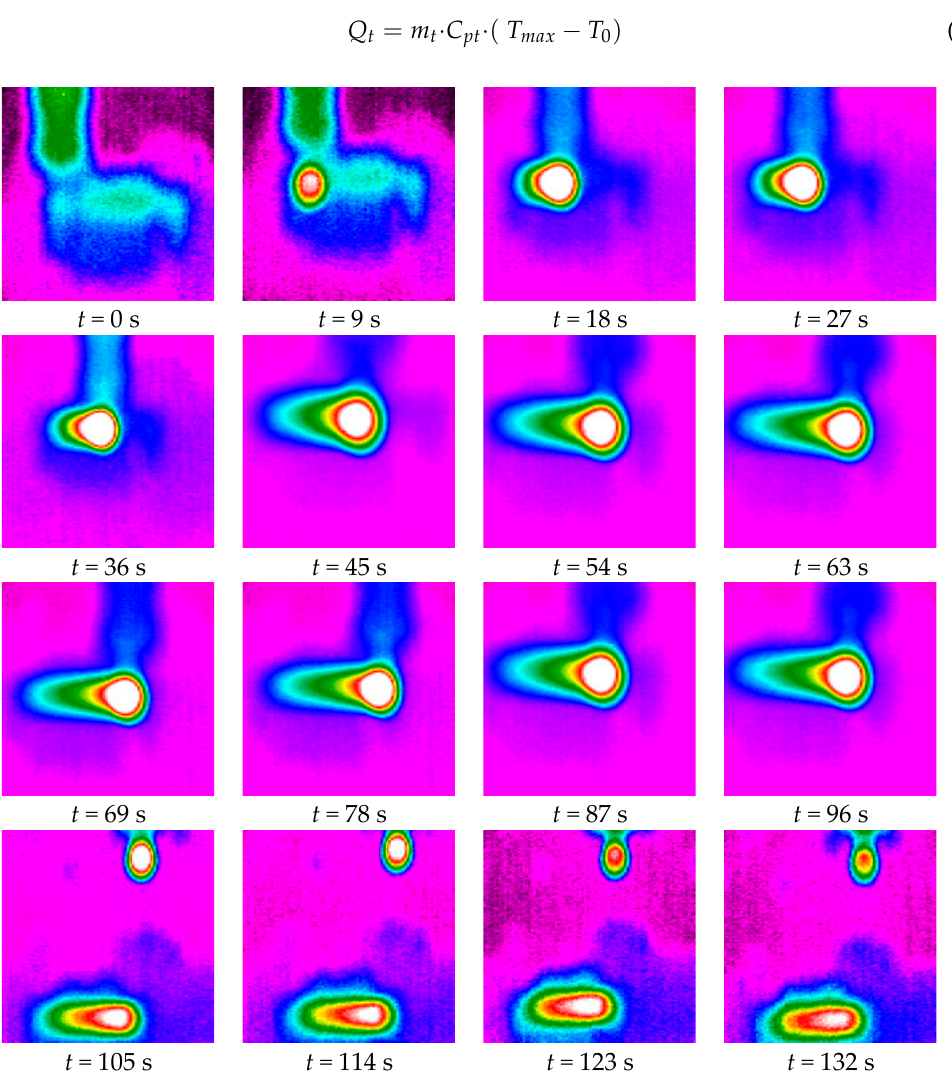
Figure 6. Thermographic shots of the edge trimming process with sampling period of 9 s .